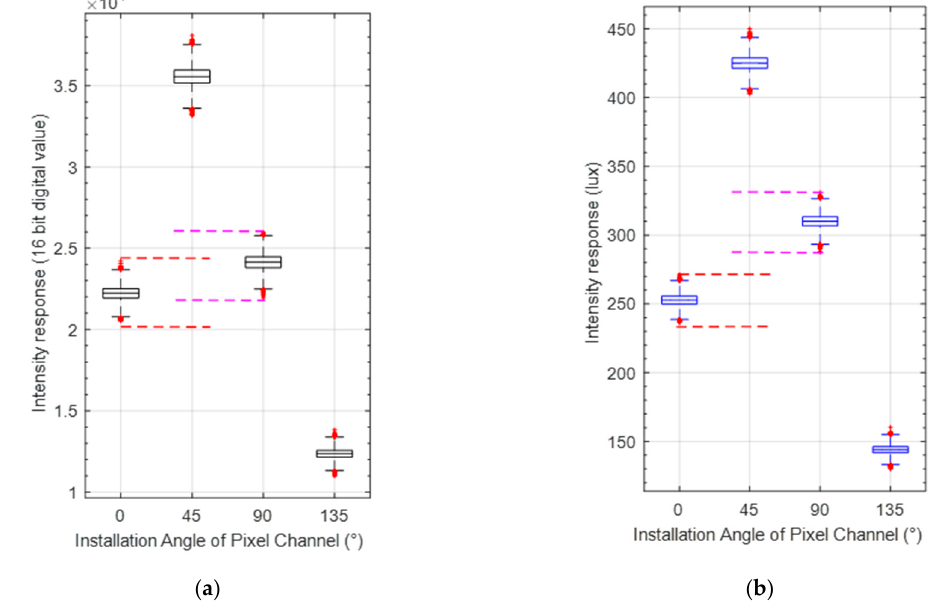
Figure 6. Distribution of light-intensity response of every pixel in single image ( a ) before calibration and ( b ) after calibration.